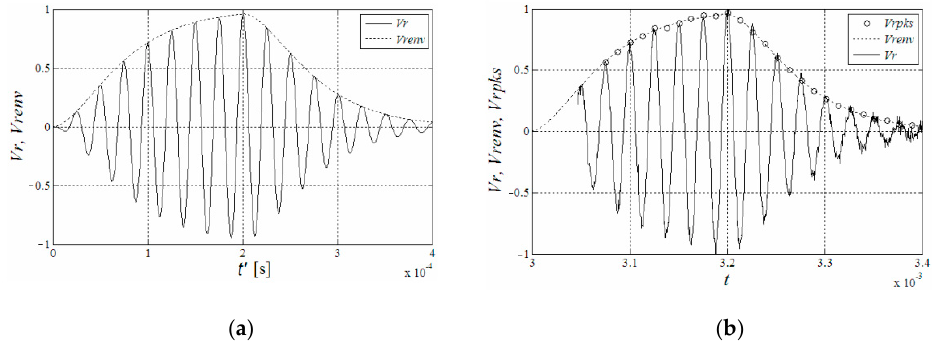
Figure 12. ( a ) An ideal model of the received signal, ( b ) An example of the fitting curve [114]. The envelope curve is simply fitted by the peak amplitude and time of each cycle, as shown in Figure 12b, or adopt the parabolic model [26]. Take the time corresponding to the point where the amplitude of the envelope curve is 0 as the initial time of the received signal.